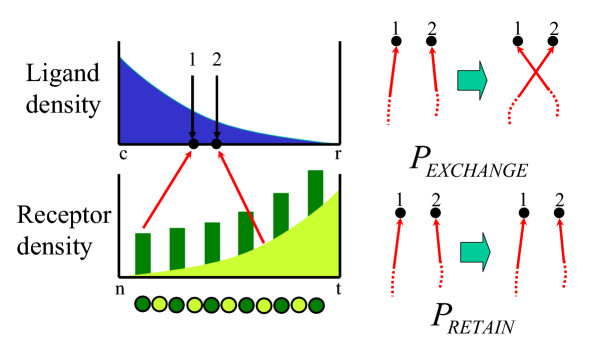
Description of the 1D model